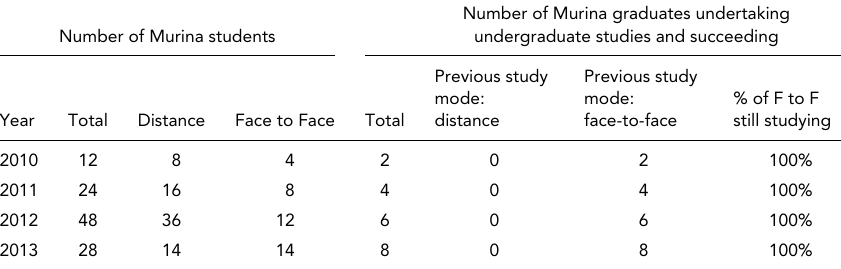
Aboriginal and Torres Strait Islander Murina Students in Undergraduate Studies Number of Murina graduates undertaking Number of Murina students undergraduate studies and succeeding Previous study Previous study mode: mode: Face to Face Total distance